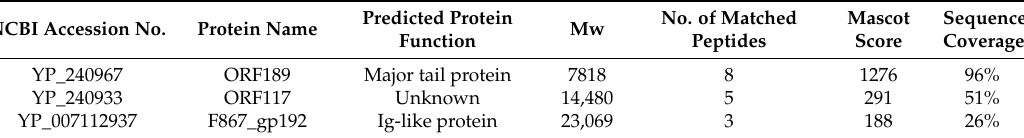
Table 4. List of proteins identified by MALDI-MS/MS after tryptic digestion of phage K1/420. NCBI Accession